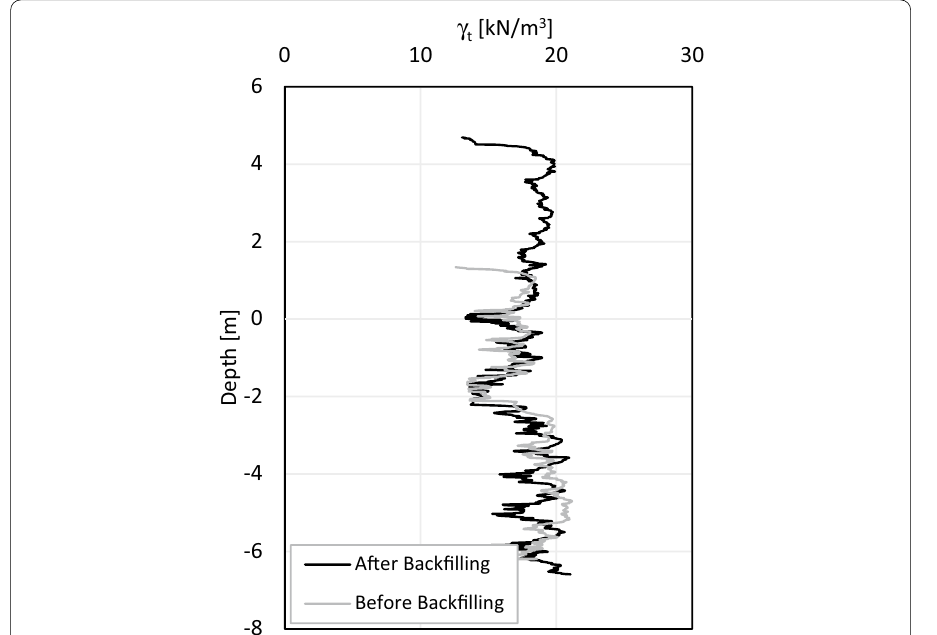
Fig. 3 Calculated saturated density of soil based on CPT results as per Eq. (10) for pre and post CPT results of case